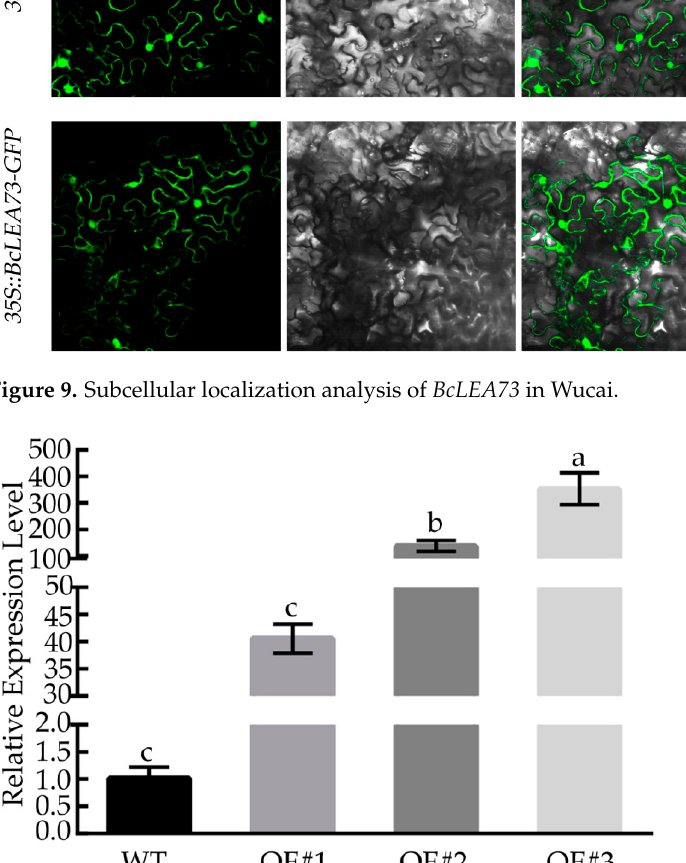
Figure 10. Relative expression level detection of transgenic Arabidopsis- resistant plants. Bars with different letters “a, b, c” above the columns indicate significant differences ( p < 0.05, Duncan’s range test) on a given day of treatment. Relative gene expression levels were calculated using the 2 − ∆∆ CT method.